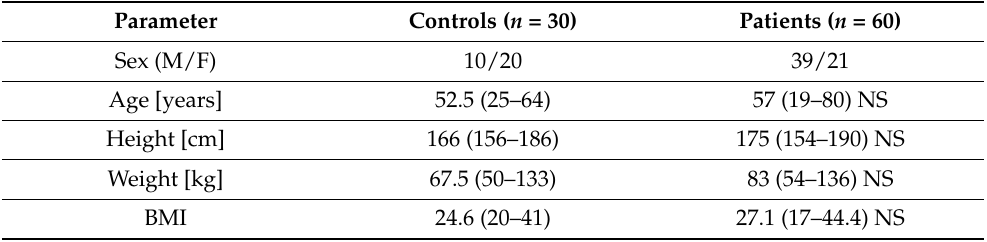
Table 1. Baseline characteristics of patients and controls.